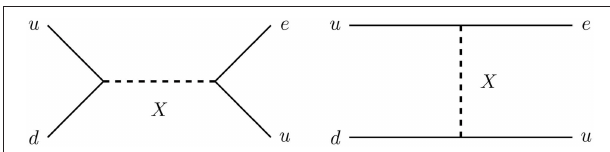
FIGURE 15 | Parton level s and t -channel diagrams for the proton decay channel p e + π 0 for a gauge or scalar boson mediator X →